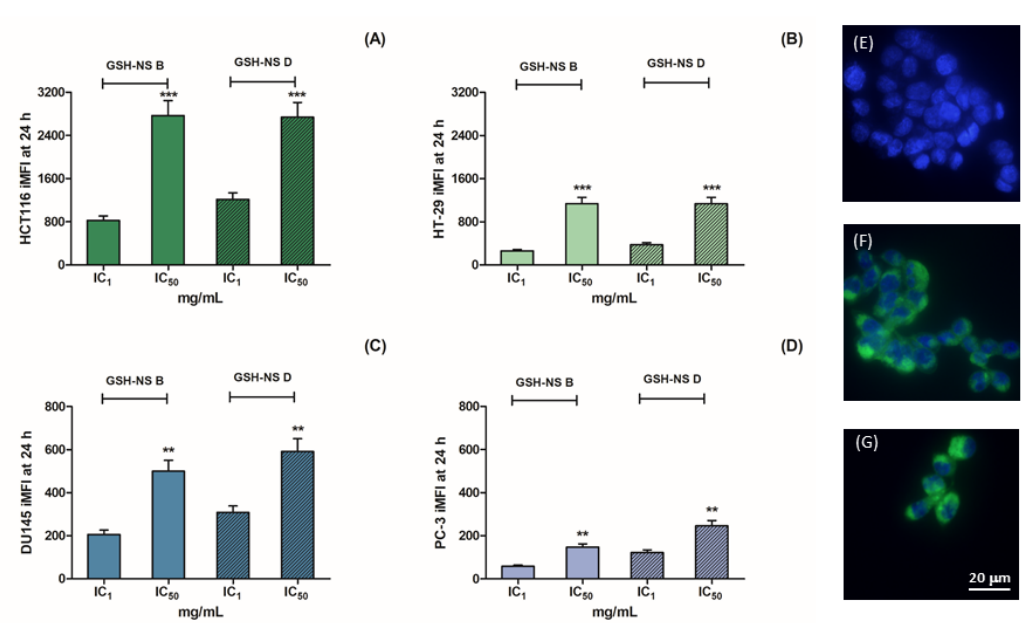
Figure 3. Fluorescent glutathione responsive β -cyclodextrin-based nanosponge cellular uptake. HCT116 ( A ), HT-29 ( B ), DU145 ( C ), and PC-3 ( D ) cells were exposed to the respective IC 1 and IC 50 of